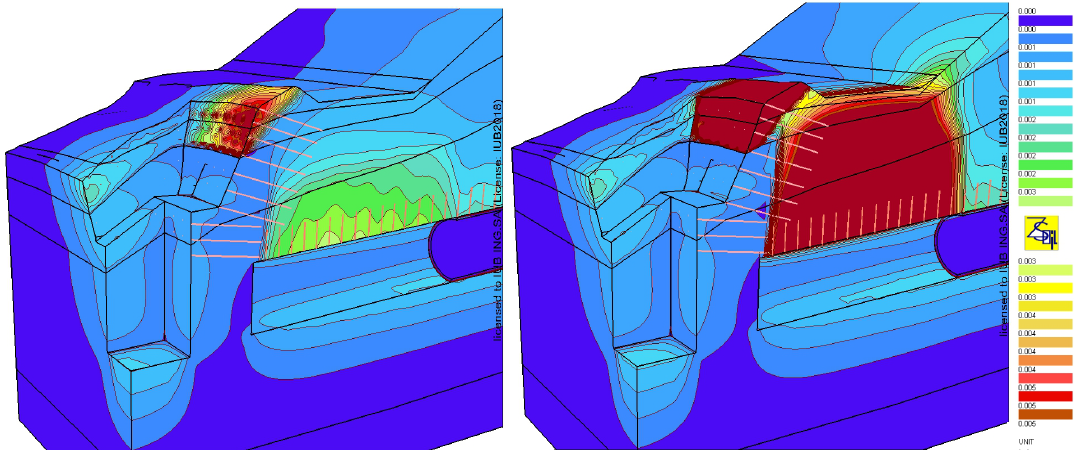
Figure 10. Slope failure of the overburden at FoS = 1.30 (left) and FoS = 1.46 (right); colours of abs. displacements as